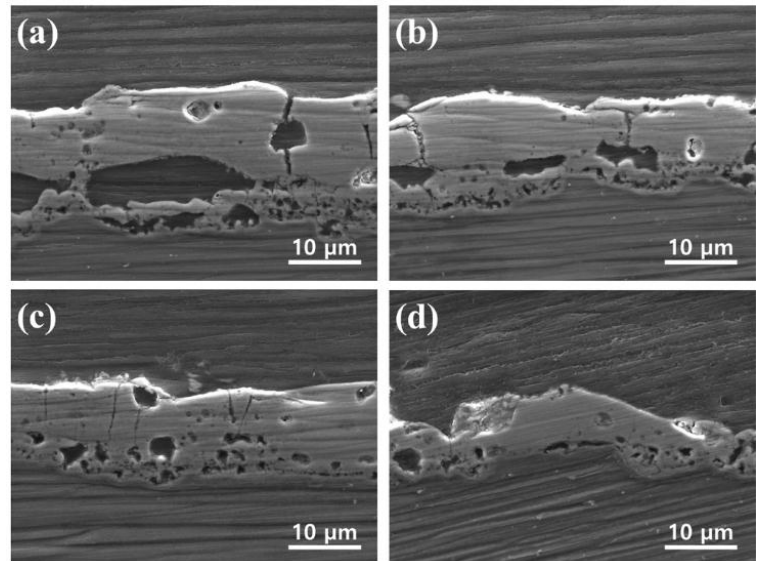
Figure 4. Scanning electron microscopy (SEM) micrographs of the surface morphologies of PEO coatings in different concentration of CNT: ( a ) 0 g/L CNT; ( b ) 2.5 g/L CNT; ( c ) 5 g/L CNT; and ( d ) 10 g/L CNT; the inset is the SEM image of the incorporated CNT.